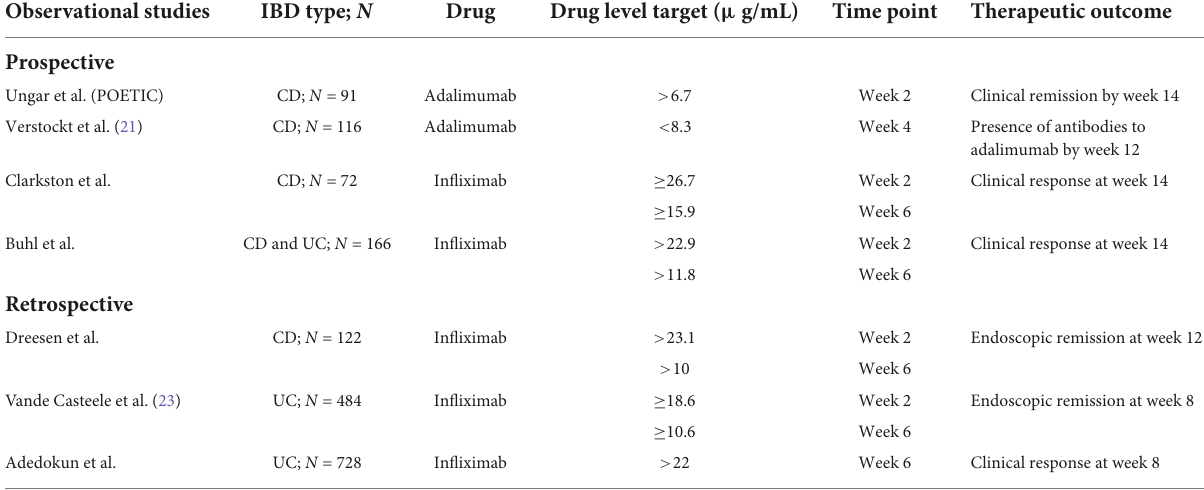
TABLE 2 Summary of main TDM studies in induction phase. Observational